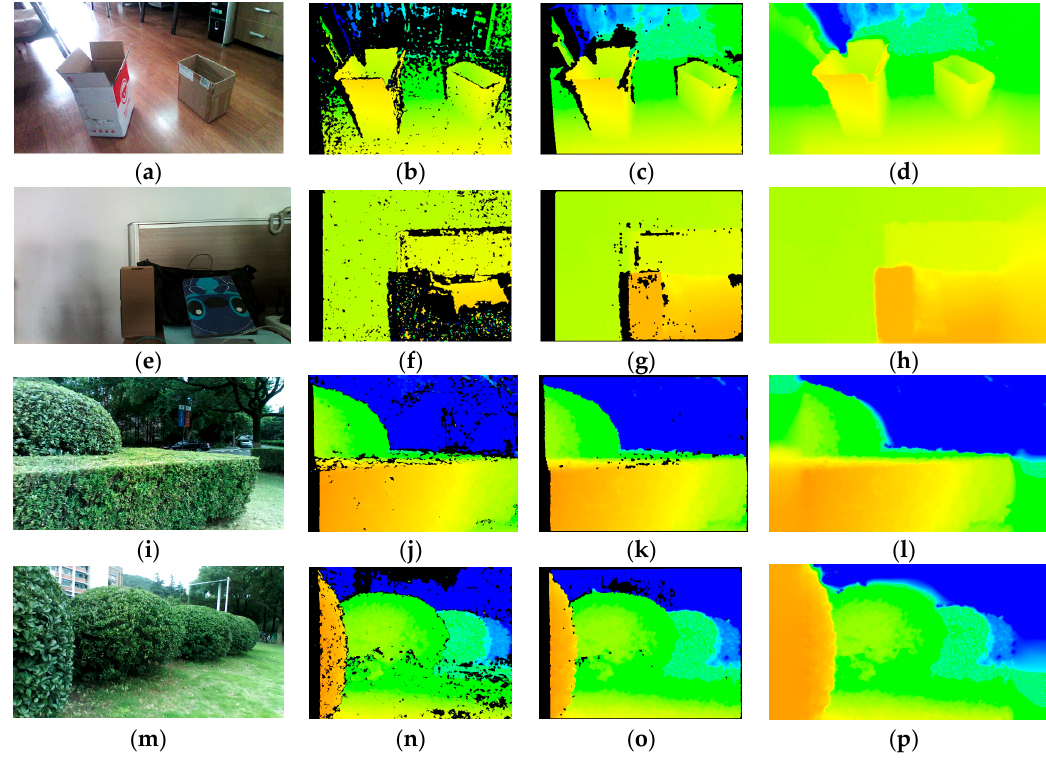
Figure 5. Comparison of depth maps under both indoor and outdoor environments. ( a , e , i , m ) Color images captured by the RealSense sensor; ( b , f , j , n ) original depth image from the RealSense sensor; ( c , g , k , o ) large-scale matched depth image; and ( d , h , l , p ) guided-filter depth image.